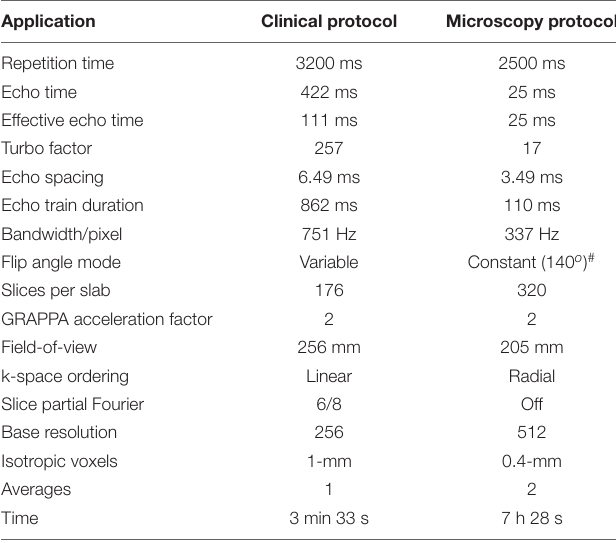
TABLE 1 | Comparison of clinical and microscopy 3D T2 SPACE sequence parameters* using clinical 3-T MRI system with 64-channel head and neck coil. Application Clinical protocol Microscopy protocol